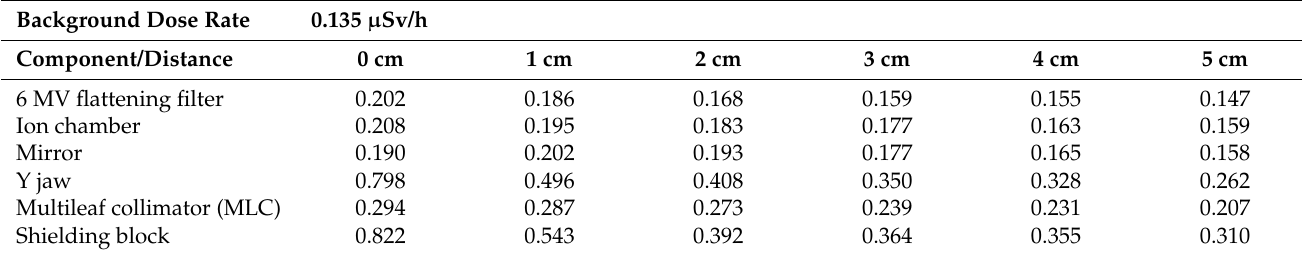
Table 4. Five weeks after disposal: Dose rate according to the distance of components (μSv/h) .